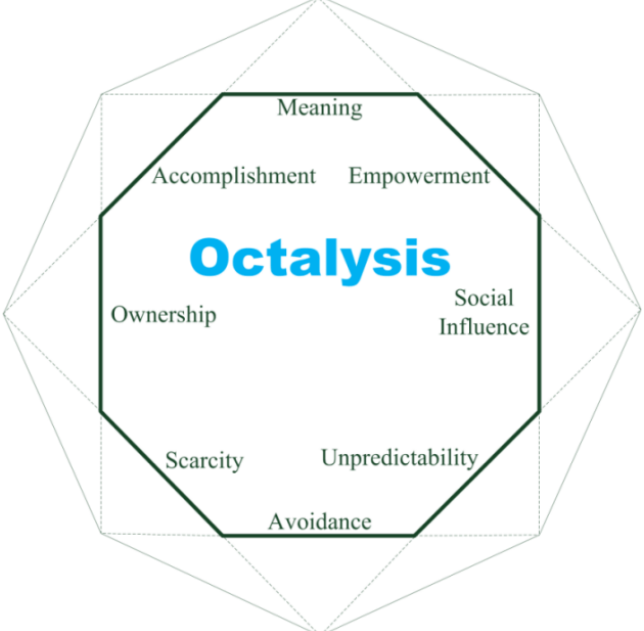
Figure 5. Octalysis diagram. Source: https://www.researchgate.net/figure/Octalysis-Gamification- framework-Chou-2015_fig2_336854026 (accessed on 6 September